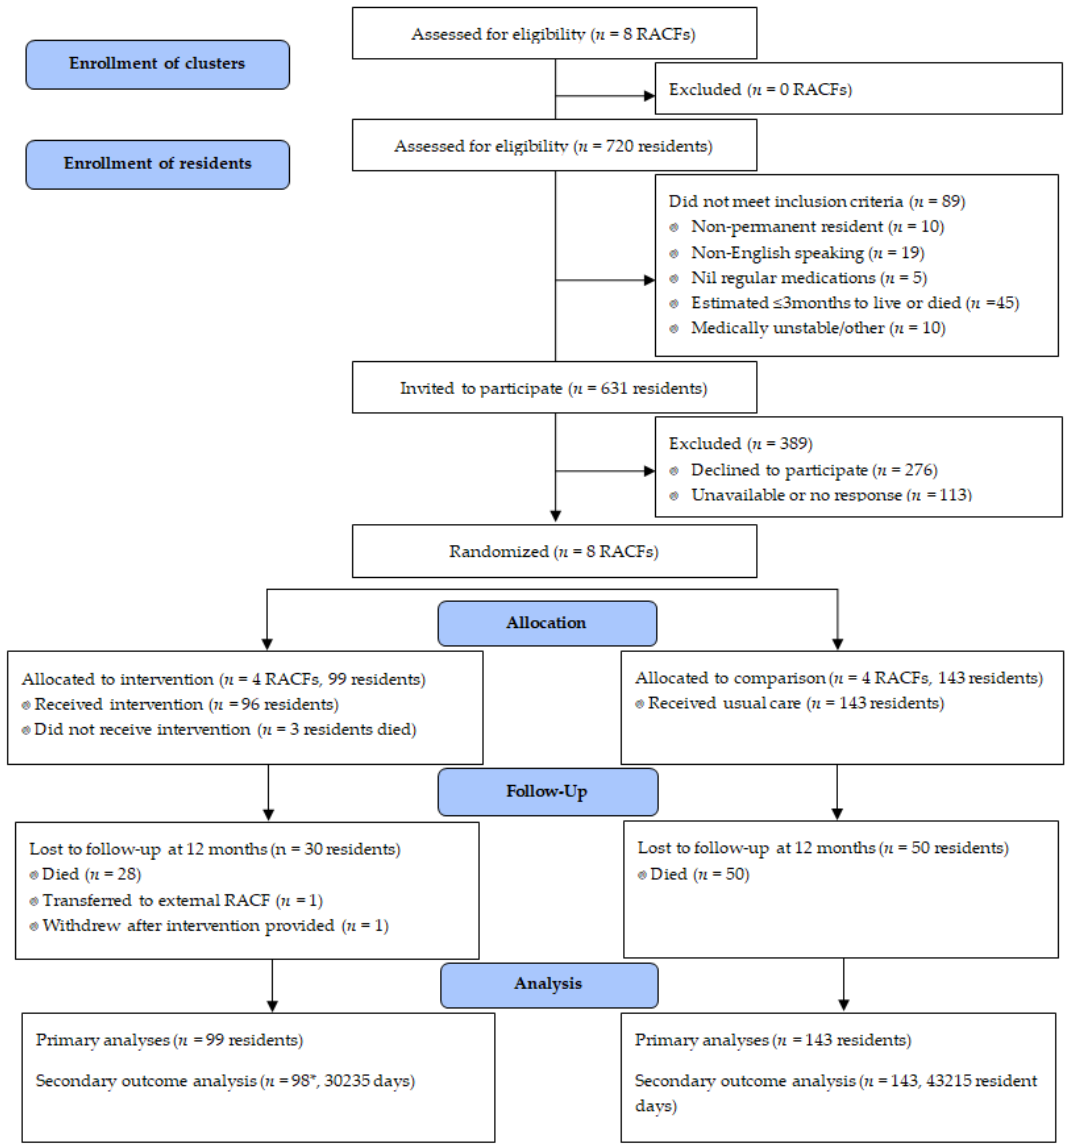
Figure 1. Study recruitment, enrolment and follow up to twelve months. * Falls, hospitalization and mortality data unavailable for one participant who withdrew; RACF, residential aged care facility. Overall, the intervention was provided to 96 of the 99 residents in the intervention arm.